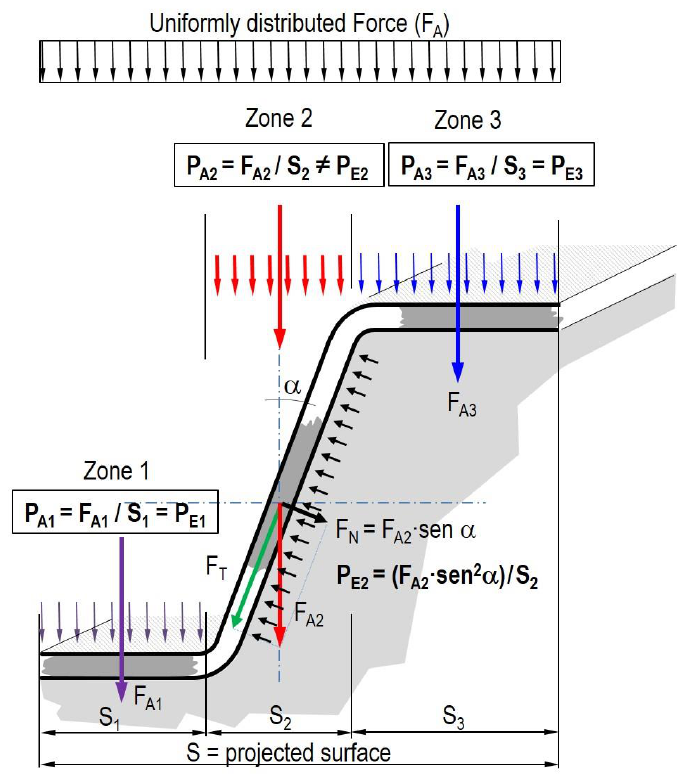
Figure 1. Schematic pressure distribution on flanges and flat areas in a hot stamped profile. “A” subscripts stand for “Apparent” and “E” subscripts stand for “Effective”.